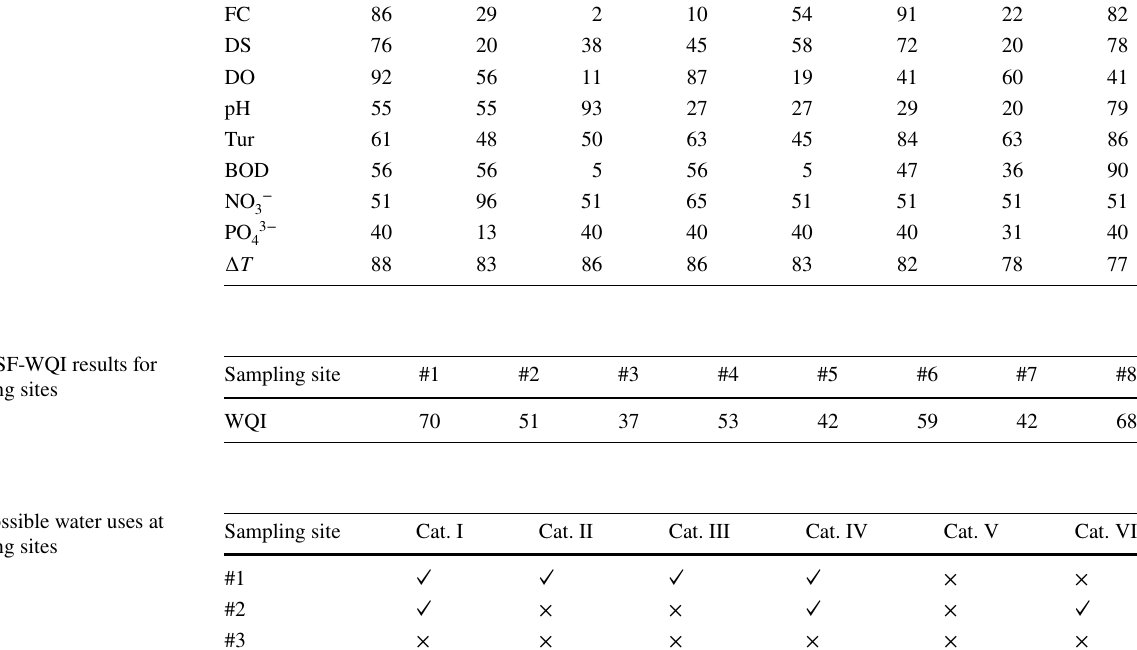
Table 7 Value of the subindex Q